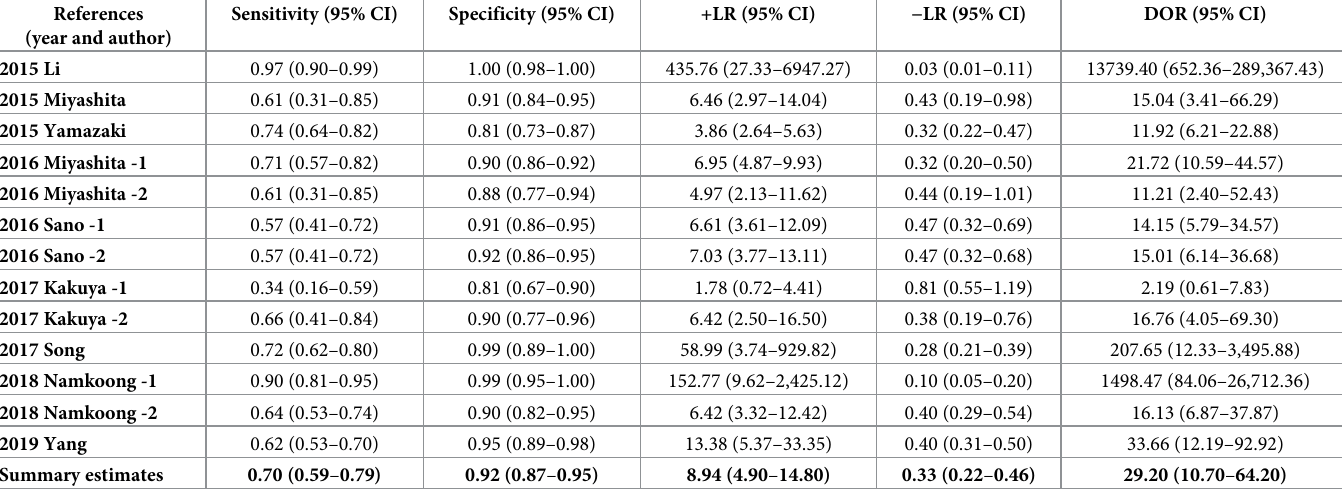
Table 2. Summary estimates of the diagnostic accuracy of immunochromatographic tests used to diagnose Mycoplasma pneumoniae